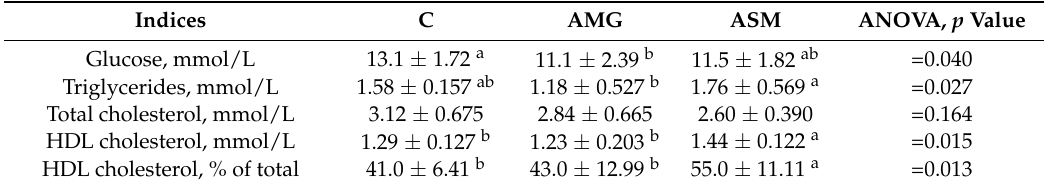
Table 4. Glucose concentration and lipid profile in the blood serum.